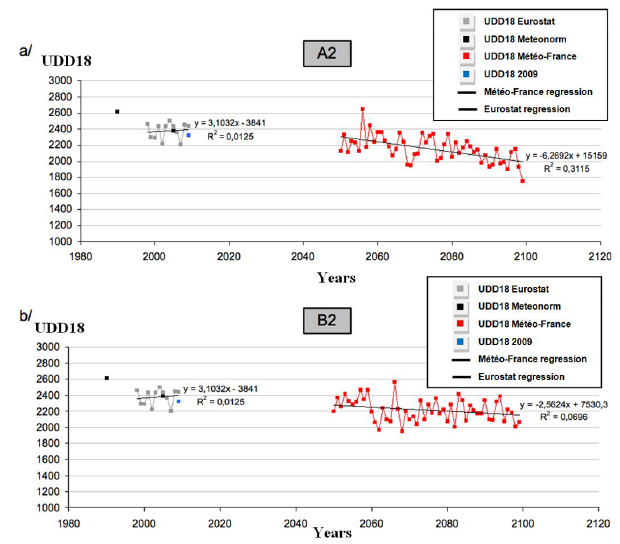
Fig. 5. Heating UDD for the scenario A2 (a) and B2 (b) in Paris.